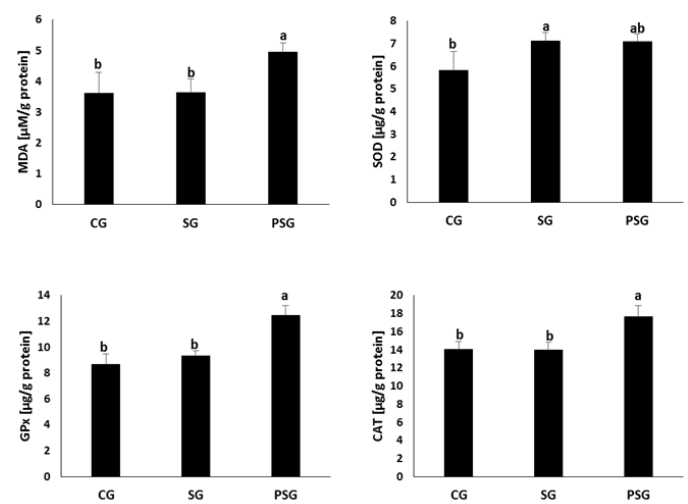
Figure 2. Effect of frequent changes in diet or periodic starvation on ovarian malonyldialdehyde (MDA) concentrations and superoxide dismutase (SOD), glutathione peroxidase (GPx), catalase (CAT) activities. CG — Control group, SG — Sugar group, PSG — Eriodically starved group, a,b — Means marked with different letters in the same line are statistically different, p ≤ 0.05.